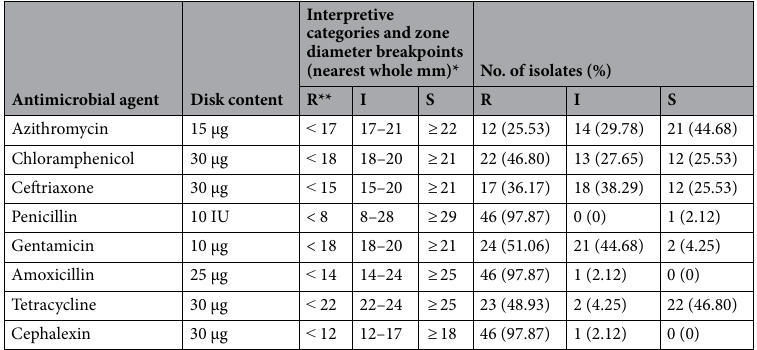
Table 4. Antibiotic resistance profile of Listeria monocytogenes isolates (n = 47) from bovine milk samples. *From CA-SFM 59 , CLSI 31 , Hansen et al. 60 , and Soussy et al. 61 . ** S susceptible, I intermediate, R resistant.